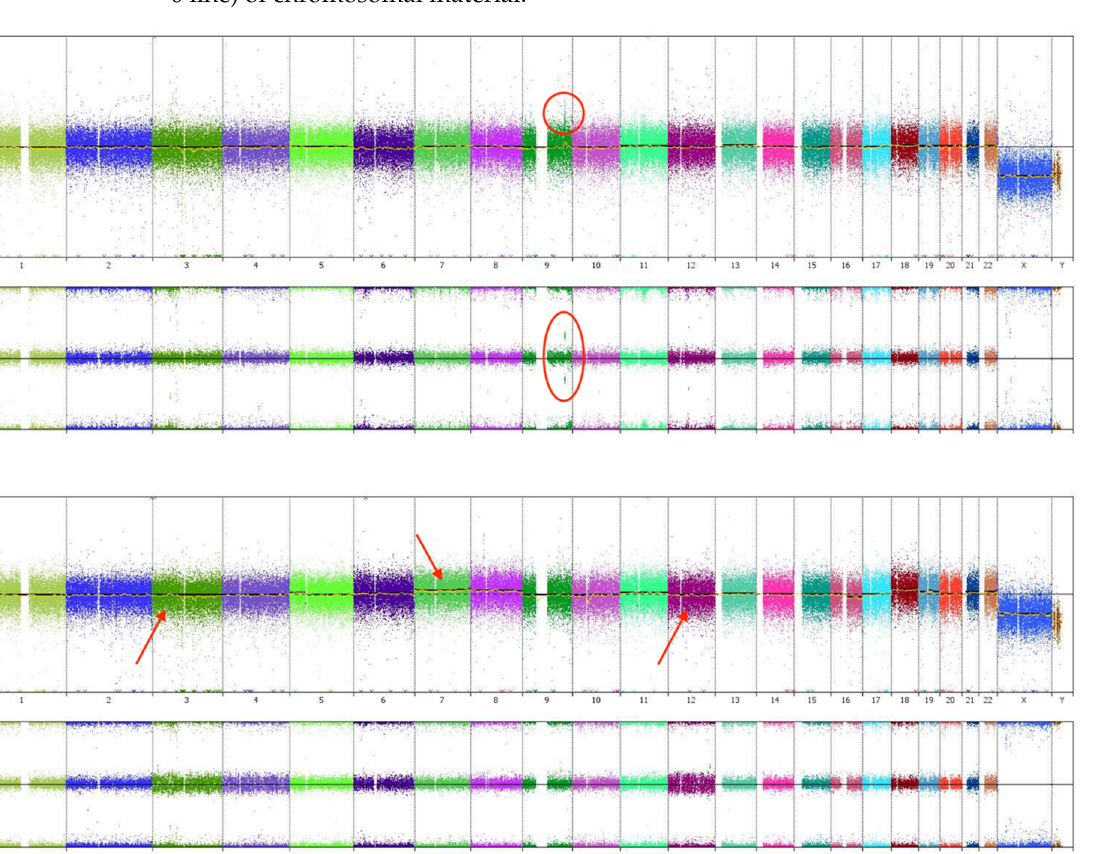
Figure 2. Melanoma from patient #2 ( A ) originating from ciliary body (insert). Tumor sample with